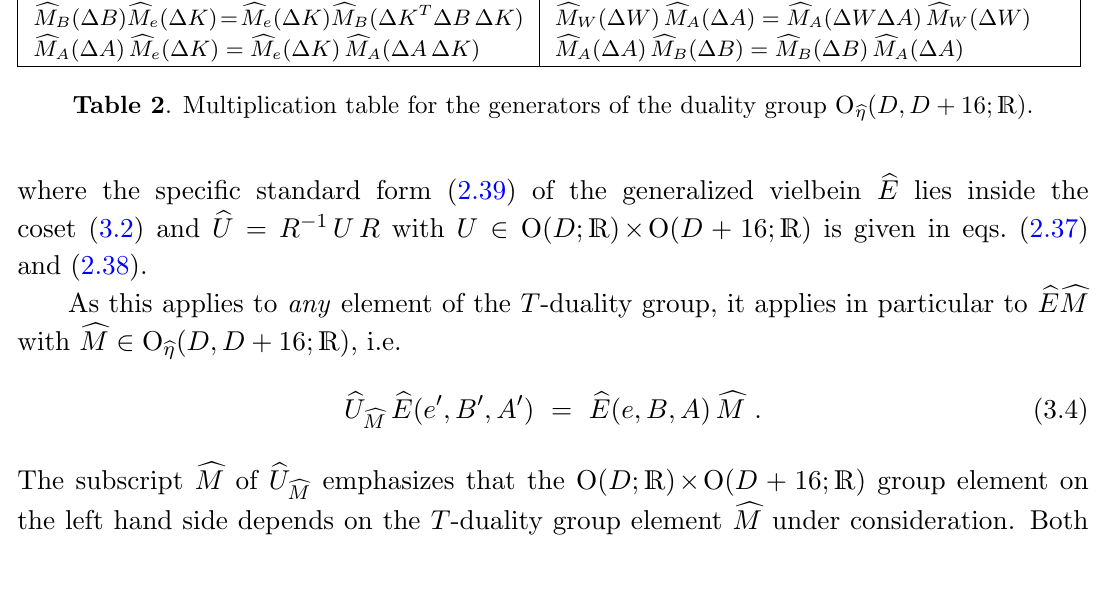
( D; D + 16; R ). b (cid:17)